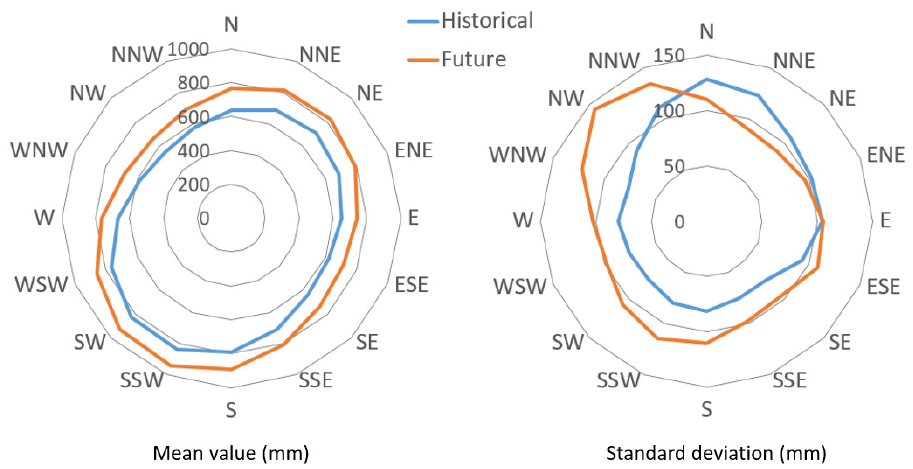
Figure 3. Wind-driven rain rose of 15 realisations of 2-year climatic data for Ottawa.